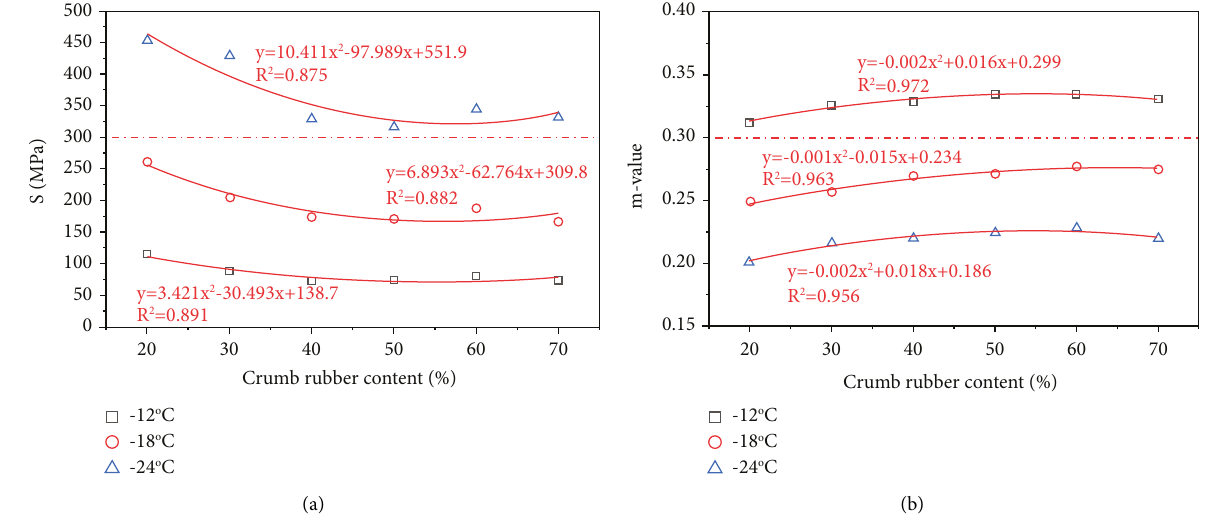
Figure 16: Results of BBR test: (a) stiffness modulus and (b) m